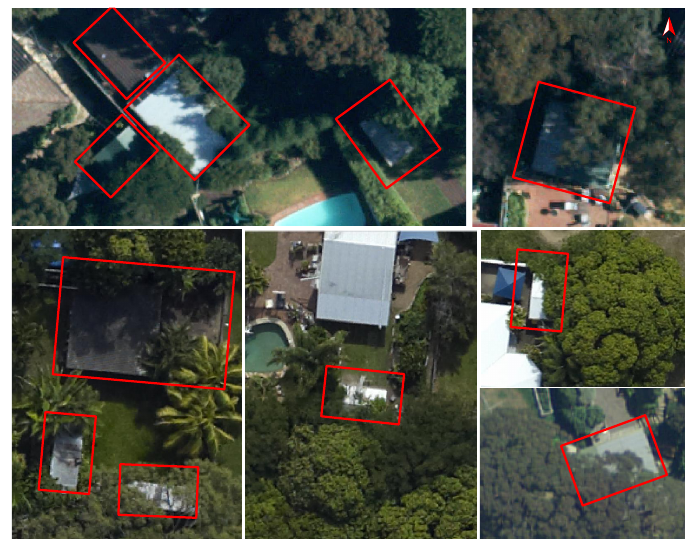
Figure 1. Complex scenarios in the Australian data sets: Partly occluded and shadowed buildings.